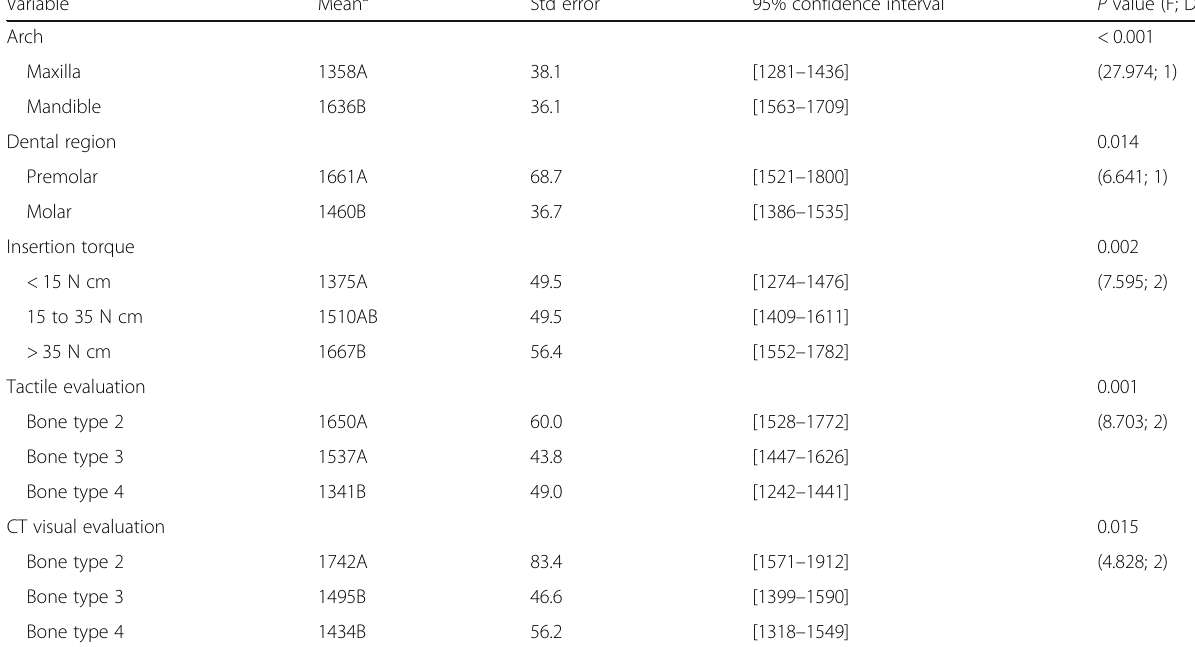
Table 3 Comparison of CT mean gray values (average of the axial, coronal, and sagittal ROIs) as a function of arch, dental region, insertion torque, and bone types as classified by CT visual assessment and by intra-surgical tactile